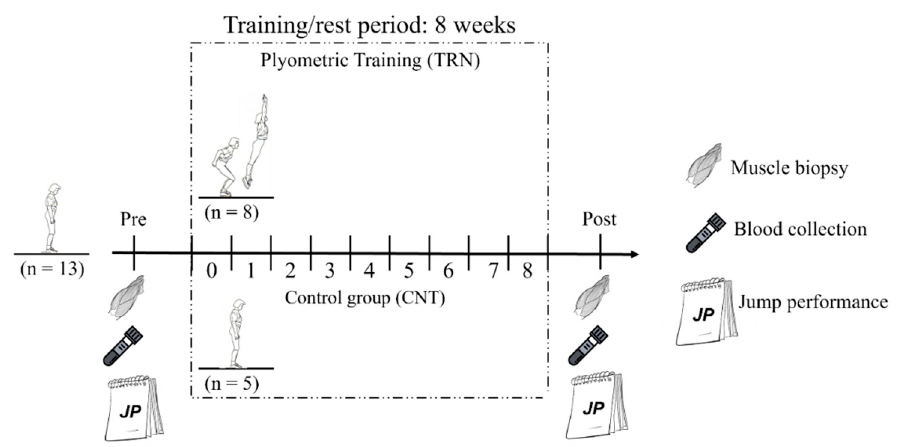
Figure 1. Study Figure 1. Study design.